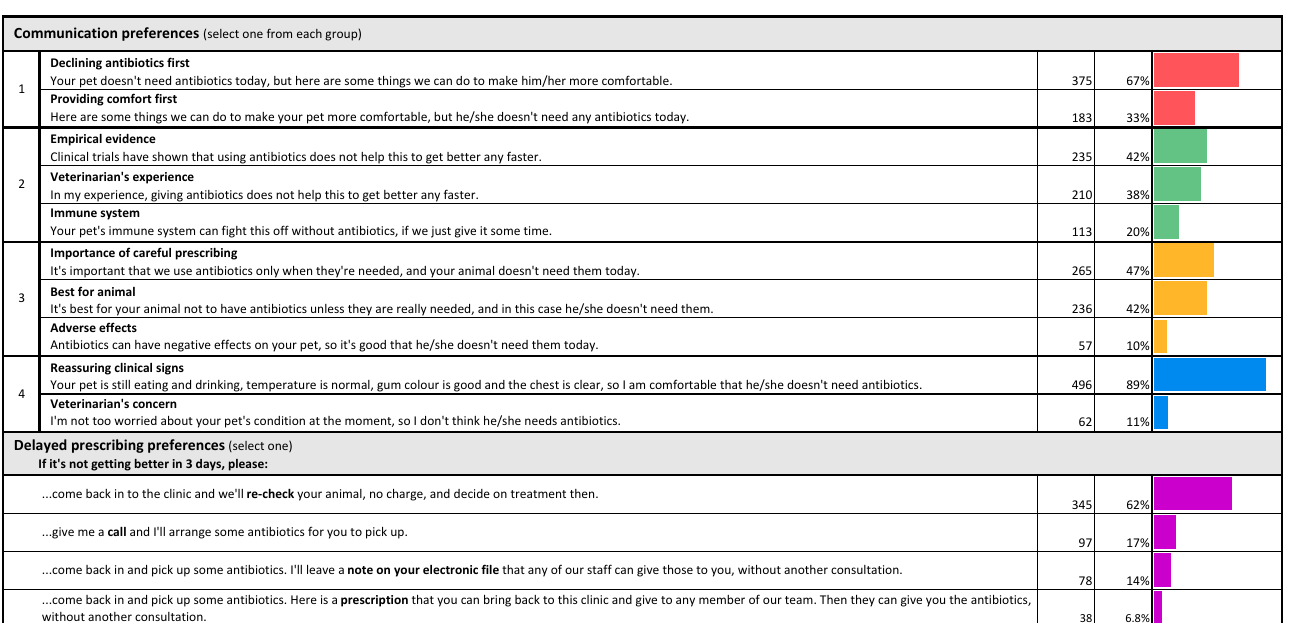
Figure 10. Communication preferences when not prescribing antibiotics, and delayed prescribing preferences. Most pet owners (67%) preferred to be told that their animal did not need antibiotics before being told about ways their pet can be made more comfortable; only 33%